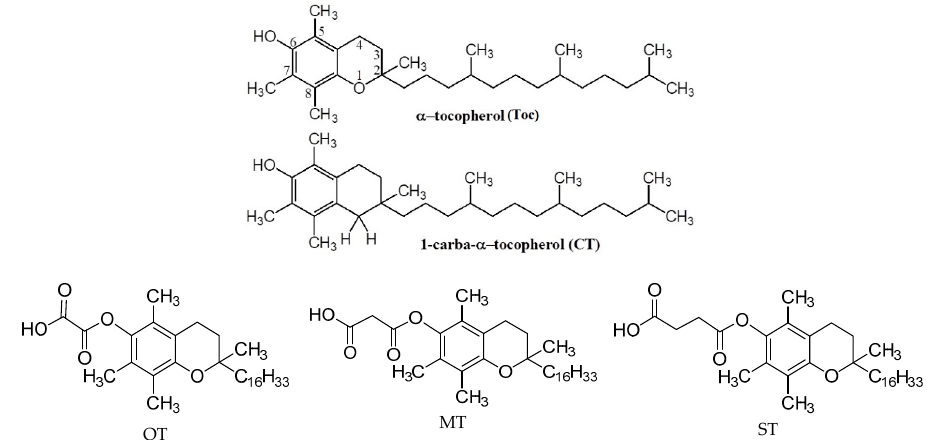
Figure 1. Chemical structures of α -tocopherol (Toc) and its derivatives: 1-carba- α -tocopherol (CT), DL- α -Tocopheryl oxalate (OT), DL- α -Tocopheryl malonate (MT), and DL- α -Tocopheryl succinate (ST).